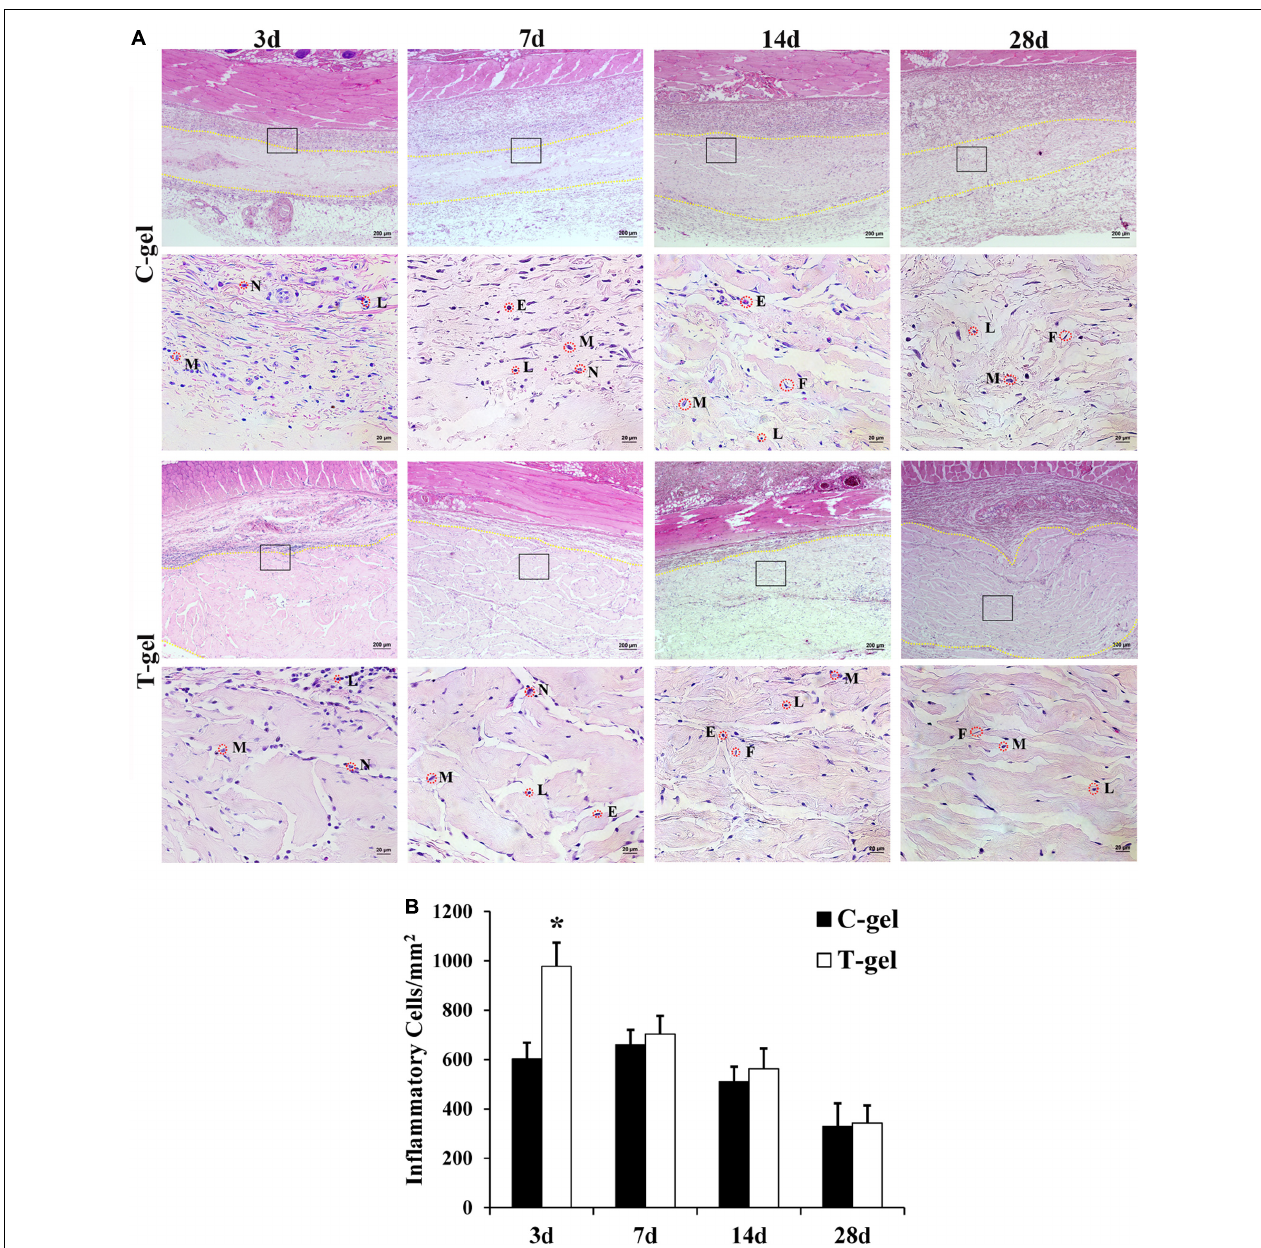
FIGURE 6 | Histocompatibility evaluation of the C-gel and T-gel. (A) Histological appearance of tissue response to the C-gel and T-gel at 3, 7, 14, and 28 days post subcutaneous implantation in a rat model as revealed by H&E staining. Images in the bottom panels (Scale bar = 20 µ m) are higher resolution images of the areas boxed in the images of top panels (Scale bar = 200 µ m). M, macrophage; N, neutrophil; L, lymphocyte; E, eosinophil; F, fibroblast. (B) Semiquantitative evaluation of tissue response to the C-gel and T-gel at each time point. Total inflammatory cells were counted with H&E staining in five randomly selected 400 × field-of-view and reported as average number per mm 2 . *Signifies a P -value of < 0.05 as compared to the